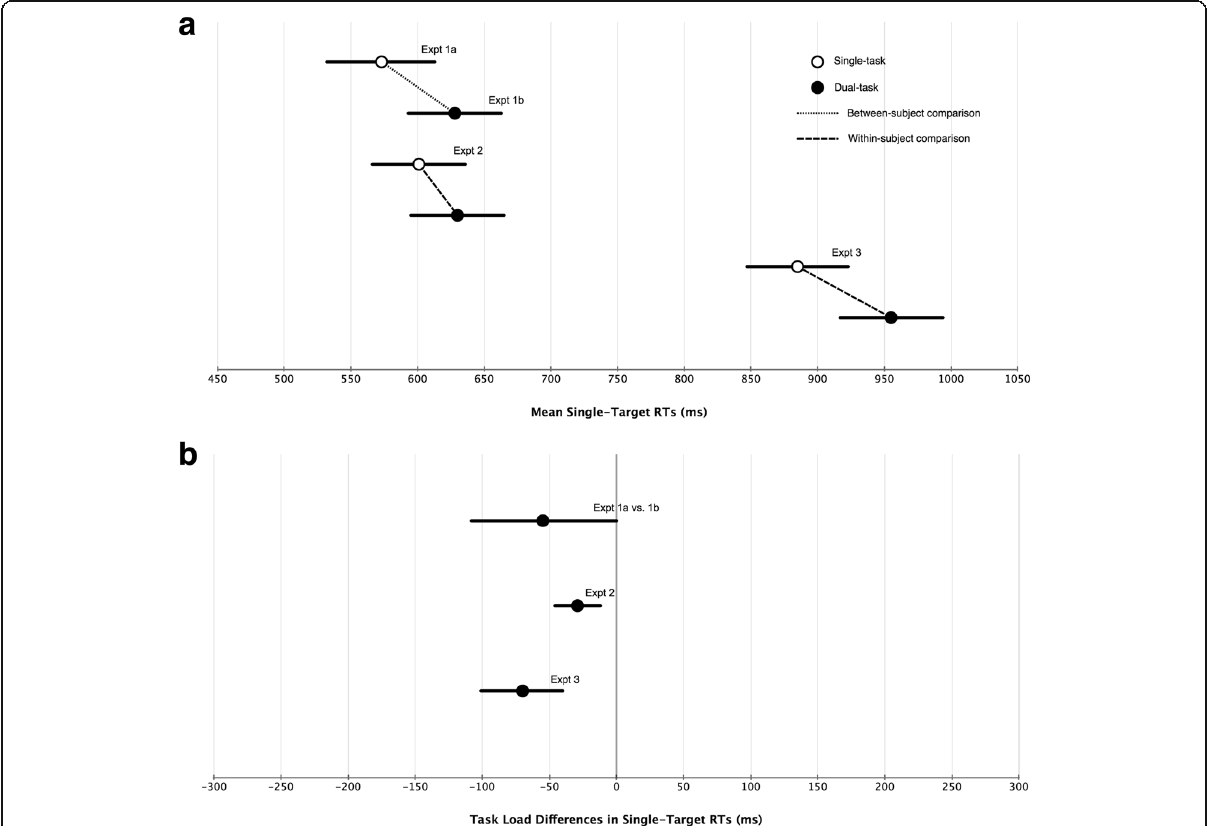
Fig. 2 a Means and 95% BCIs for single-target RTs (ms) in each experiment. b Means and 95% BCIs on the task-load difference scores for single- target RTs in each experiment (single-task RT minus dual-task